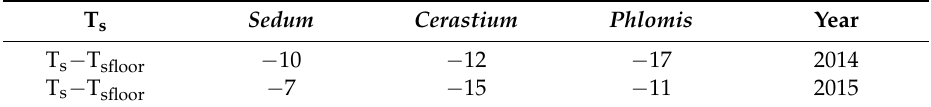
Table 3. Surface thermal gradients between surface temperature of the plant species (T s ) and paved surface temperature (T sfloor ), 4 August 2014 and 9 May 2015.